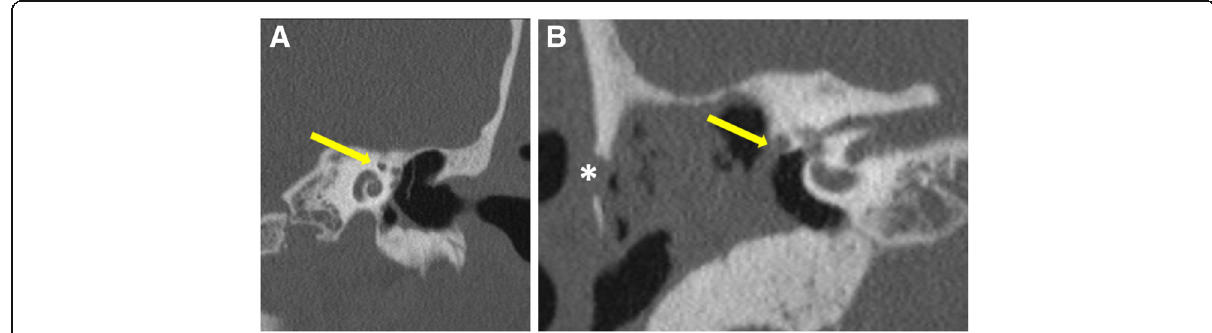
Fig. 9 Coronal ( a ) CT image reveals the “ snail eye ” view where the turns of cochlea form the body of snail and labyrinthine and tympanic segments of facial nerve being the eyes (arrow). Coronal ( b ) CT image shows the erosion of the floor of the horizontal segment of the facial canal (arrow). Erosion of lateral mastoid cortex is also seen (asterisk)